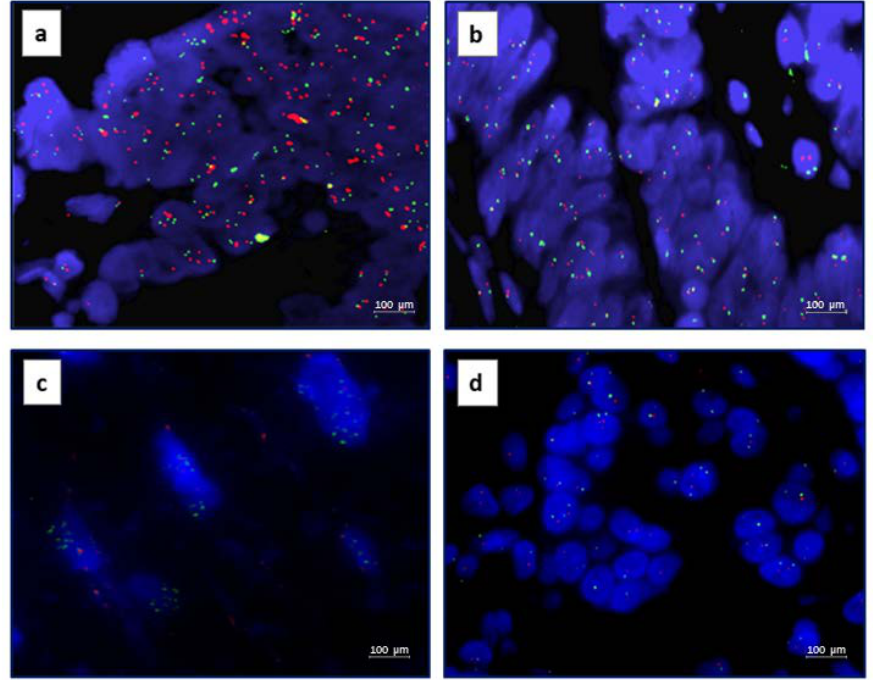
Figure 2. Representative FISH results (original magnification 100 × ). ( a ) AXL gene amplification; ( b ) AXL gene no amplificated; ( c ) MET gene amplification; ( d ) MET gene no amplificated.